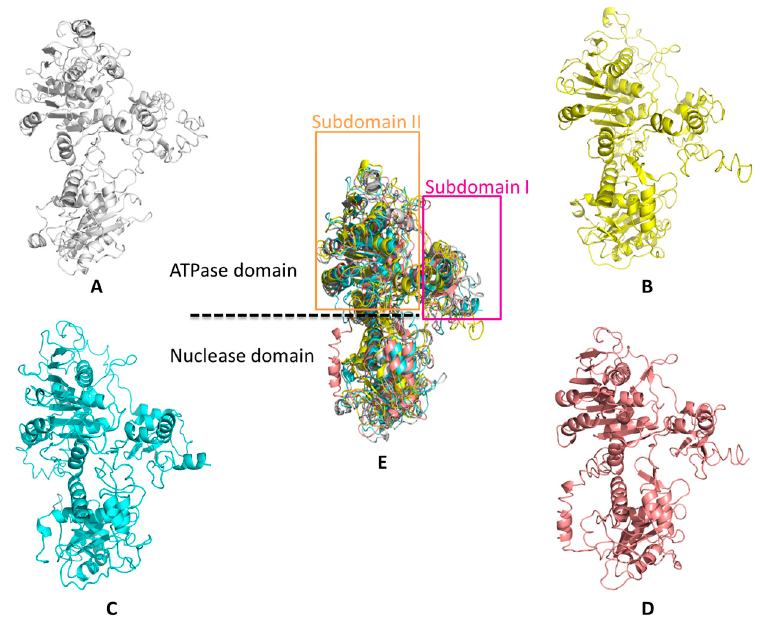
Figure 4. Structural comparison of pUL15 of the four viruses using PyMOL. ( A – D ) The pUL15 structures of HSV-1 UL15, HCMV UL89, EBV BGRF1/BDRF1, and T4 Gp17 are represented in gray, yellow, light blue, and pink, respectively. ( E ) Superposition of the HSV-1 UL15C nuclease with large terminase nuclease from HCMV, EBV, and T4. The N-terminal region of the large subunit of the terminase is mainly above the dotted line and mainly contains the ATPase domain. The C-terminal region of the large subunit of the terminase is mainly below the dotted line and mainly contains a nuclease domain.